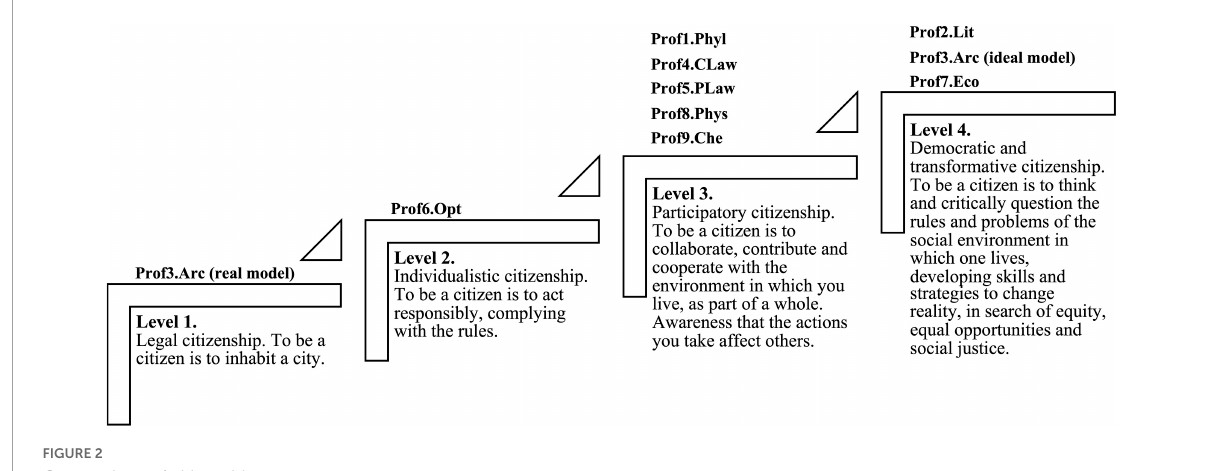
FIGURE2 Conceptions of